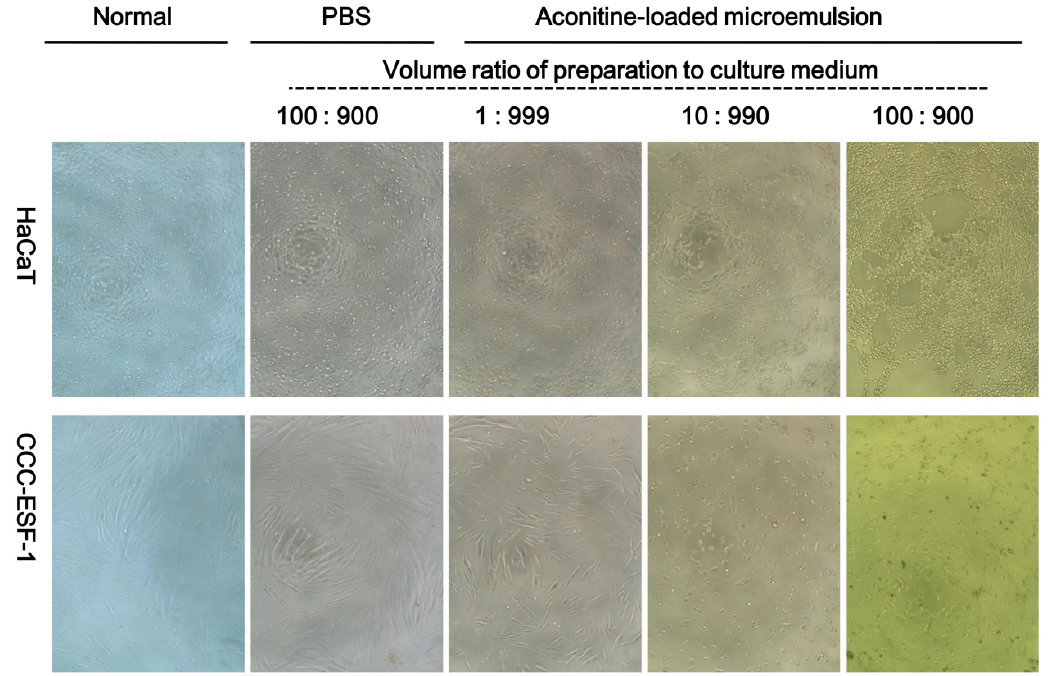
Figure 7. HaCaT and CCC-ESF-1 cell morphology after being incubated with aconitine-loaded microemulsion for 24 h. Magnification ×100.